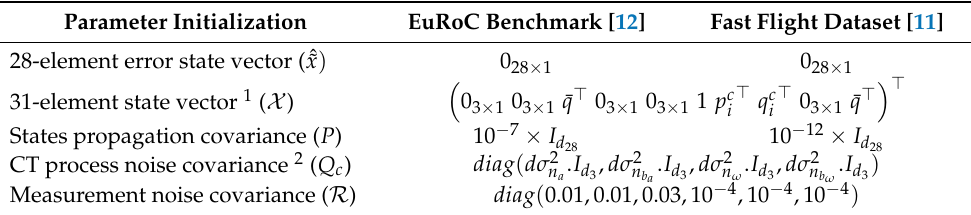
Table 2. The ES-EKF initialization parameters for both the EuRoC and Fast Flight